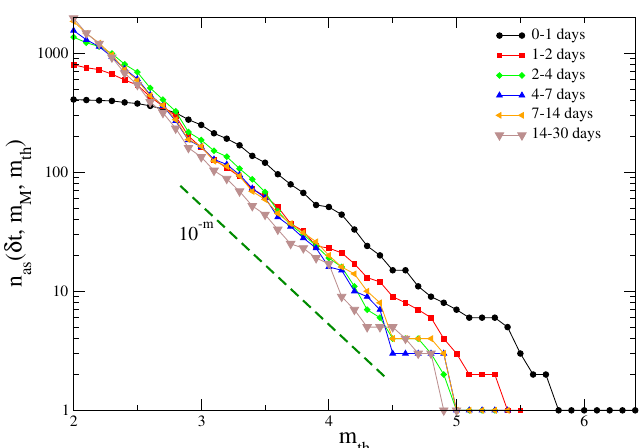
Figure 2. The number of aftershocks with magnitude larger than m th for the m M = 7.3 Landers earthquake in Southern California, evaluated in different temporal windows δ t from the main shock. The green dashed line is the exponential behavior expected according to the GR law with b =